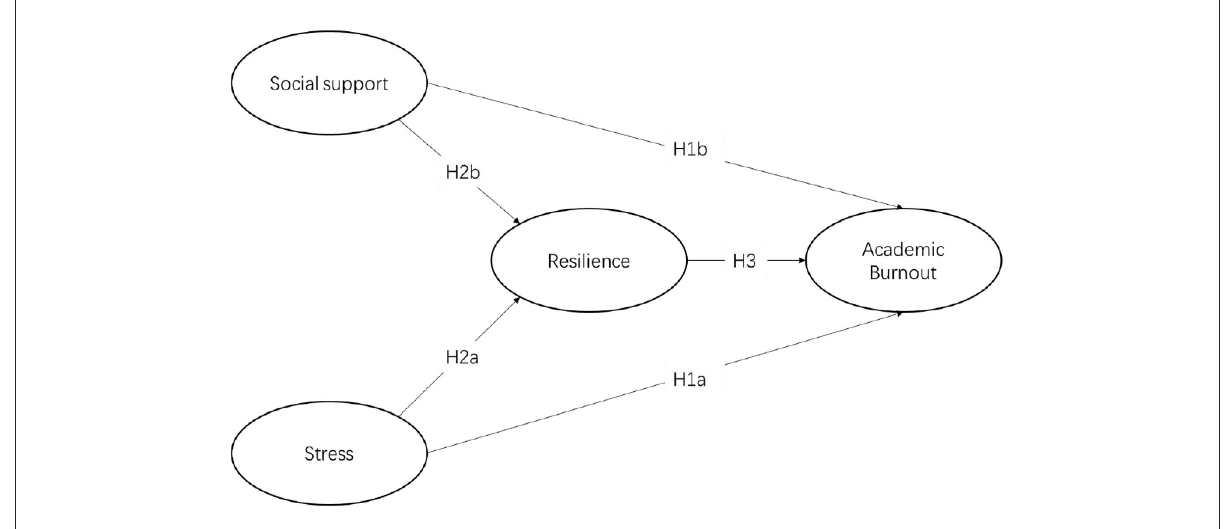
FIGURE1 Hypothesized